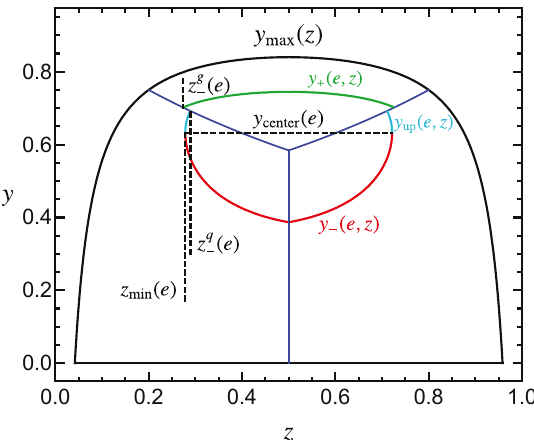
Figure 11 . Phase space diagram in ( z; y ) coordinates (black curves) split by blue lines into regions in which the thrust axis points in the direction of the quark, anti-quark or gluon momenta. In green, cyan and red we show the contour lines for constant value of (cid:28) E corresponding to the functions y + ( e; z ), y up ( e; z ) and y (cid:0) ( e; z ), respectively. The cyan and green curves do not meet